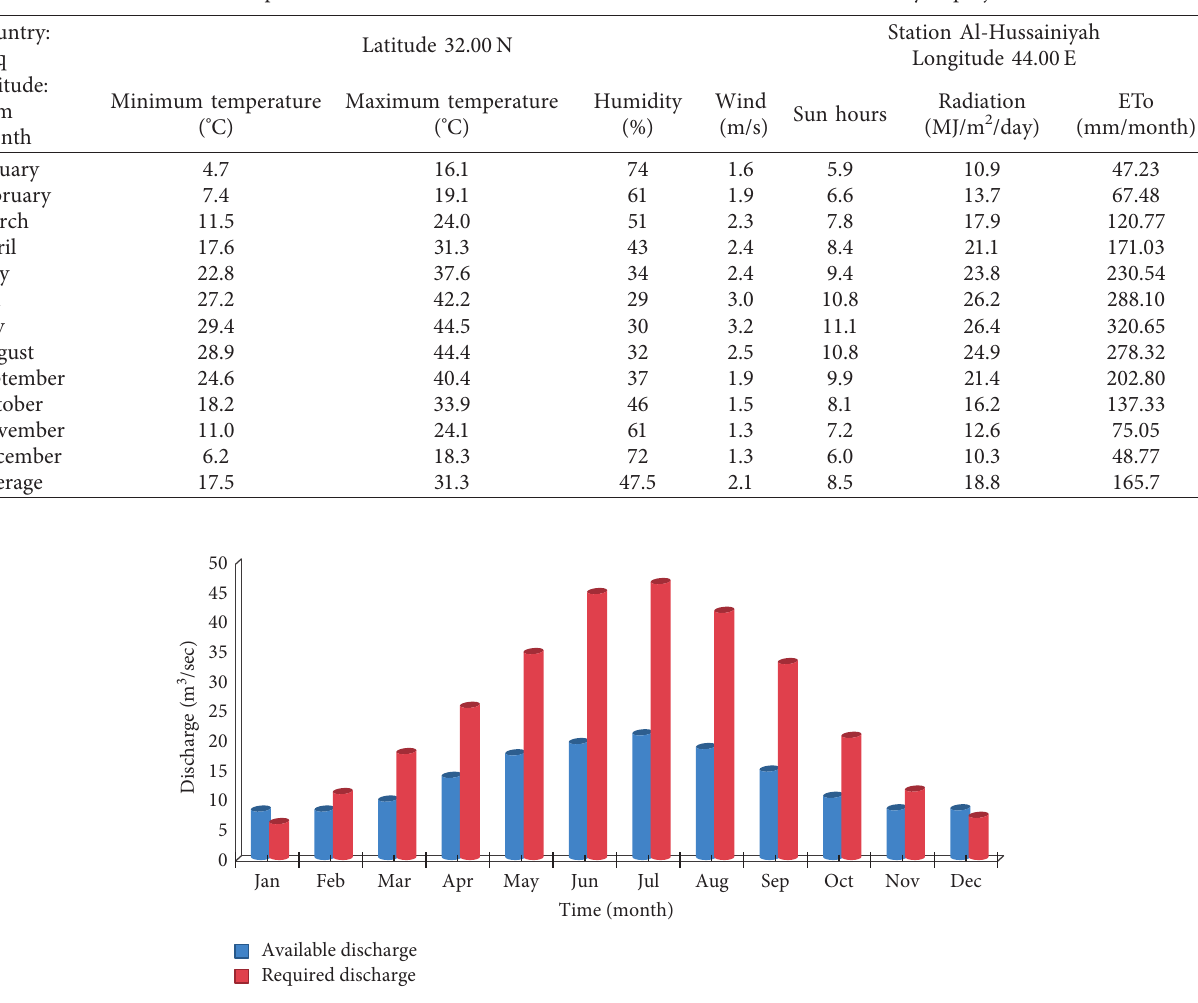
Figure 3: Requirements of discharge at the head of the main canal for the period from 2012 to 2018. Table 8: Estimated yield reduction % with total gross irrigation (mm) in medium